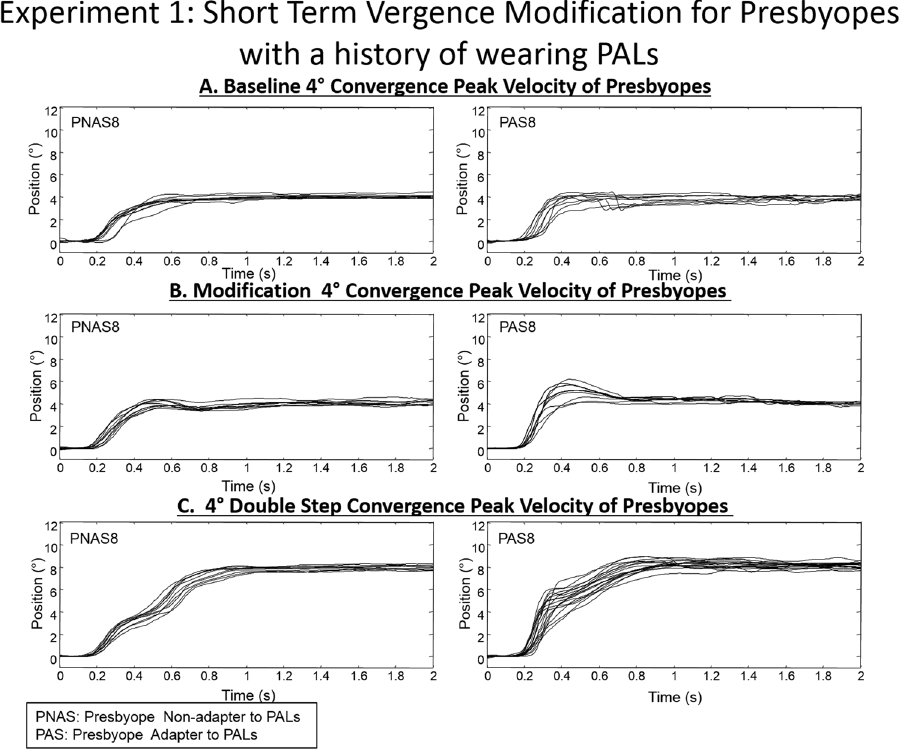
Figure 2. Ensemble plots for 4° single and double convergence responses from a subject from the PNAS (left column) and PAS (right column) groups for Experiment